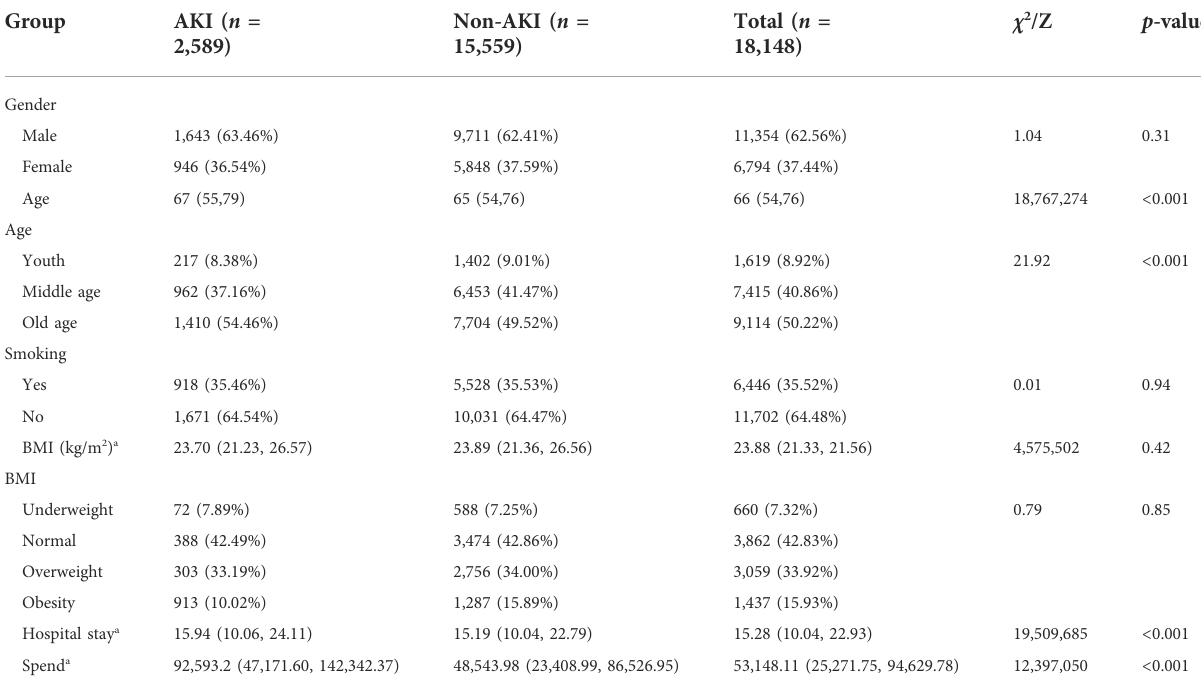
TABLE 1 Diuretics related AKI and patient